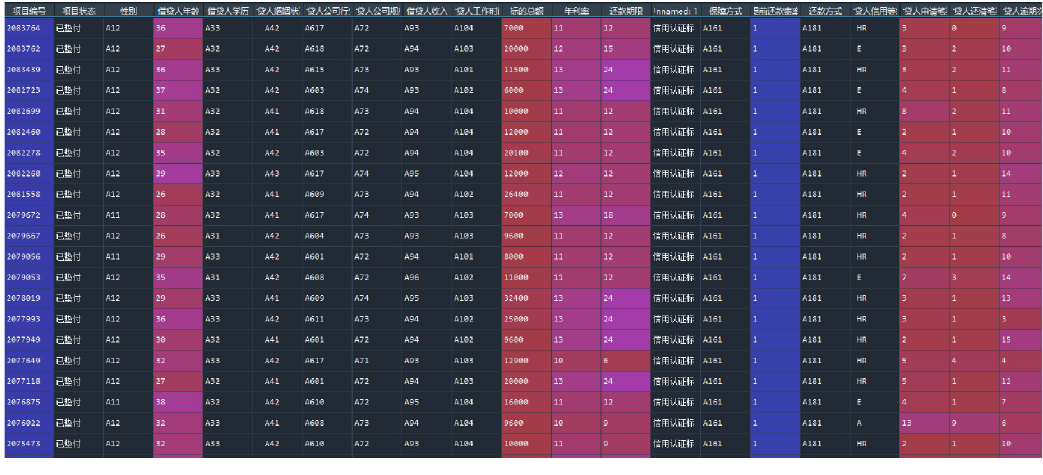
Fig 17. First read Excel data.